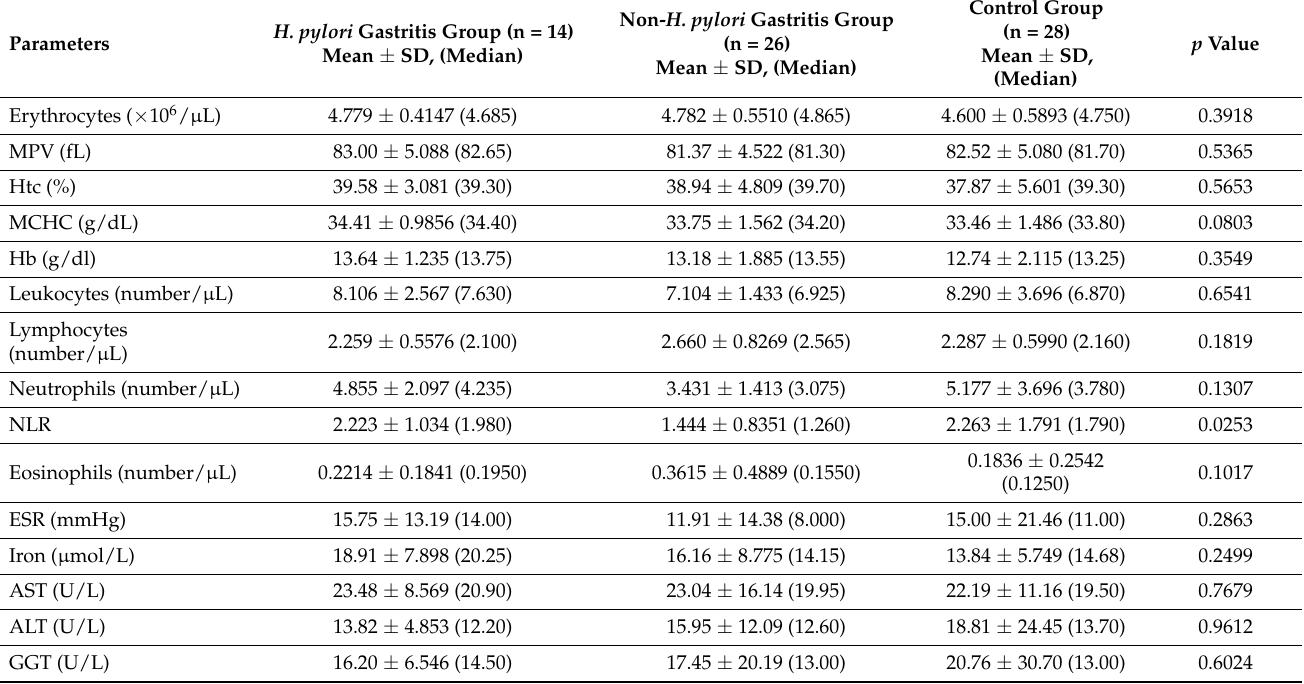
Table 2. Demographic characteristics of the three groups.